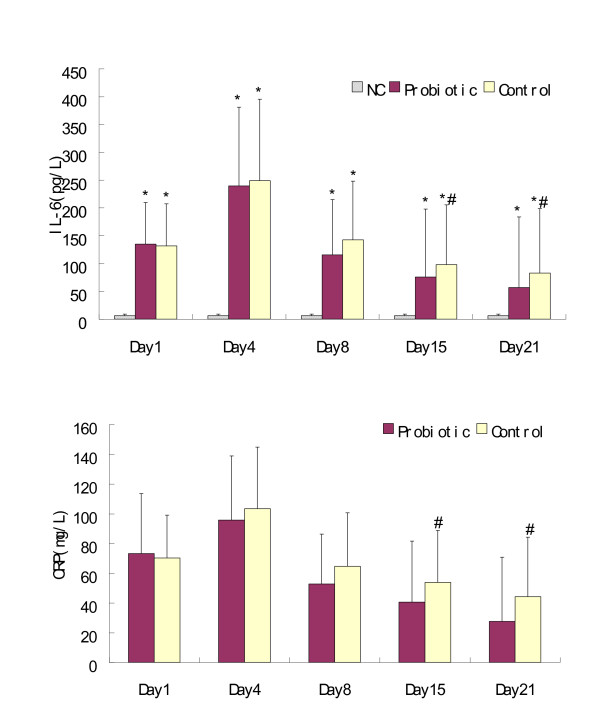
Serum IL-6 and C-reactive protein concentrations. Mean ± standard deviation. CRP, C-reactive protein. *P < 0.05, compared with normal controls (NC). #P < 0.05, compared with the probiotic group.